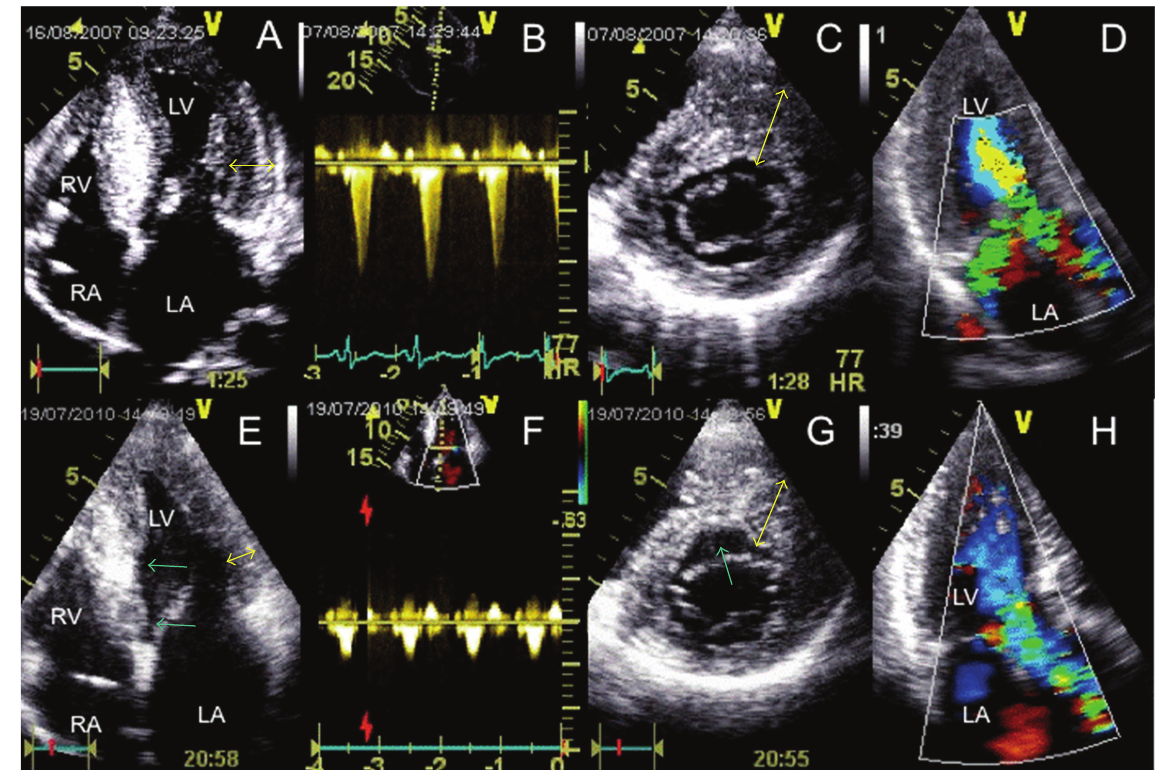
Figure 1: Upper panel (A–D): HOCM with severe hypertrophy of the left ventricle at baseline, particularly involving the septum ((A) and (C)) and exceeding the “critical” threshold of 30mm (double arrow in (C)). (A) four-chamber view, (B) cw-Doppler profile of LVOT flow with a resting gradient of 70 mmHg, (C) short-axis view in diastole with double arrow pointing to anterior septal hypertrophy, (D) apical long axis with the turbulent LVOT jet and the obstruction-associated mitral regurgitation. Lower panel (E–H): two years after successful septal ablation which has left a myectomy-like trough in the basal septum (arrows in (E) and (G)) and completely eliminated outflow gradient (F) and mitral regurgitation (H), regression of left ventricular hypertrophy can be observed both in the septum (double arrows in (G)), and the lateral wall (double arrow in (E)). LA: left atrium RA: right atrium RV: right ventricle LV left